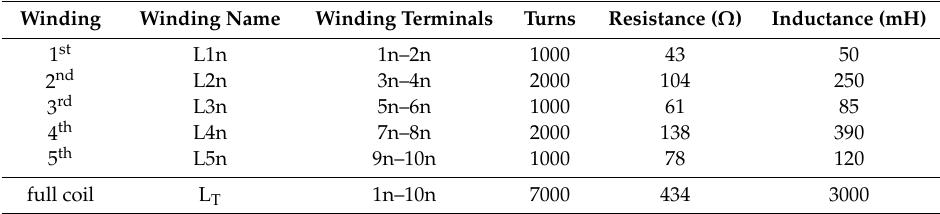
Table 1. Winding parameters of the coil of a single n-transducer, n = {a, b, c}.